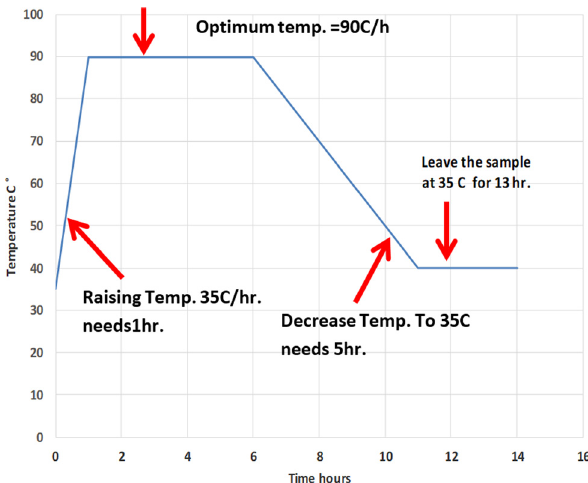
Figure 4: Relationship between the fl ow and glass powder % for